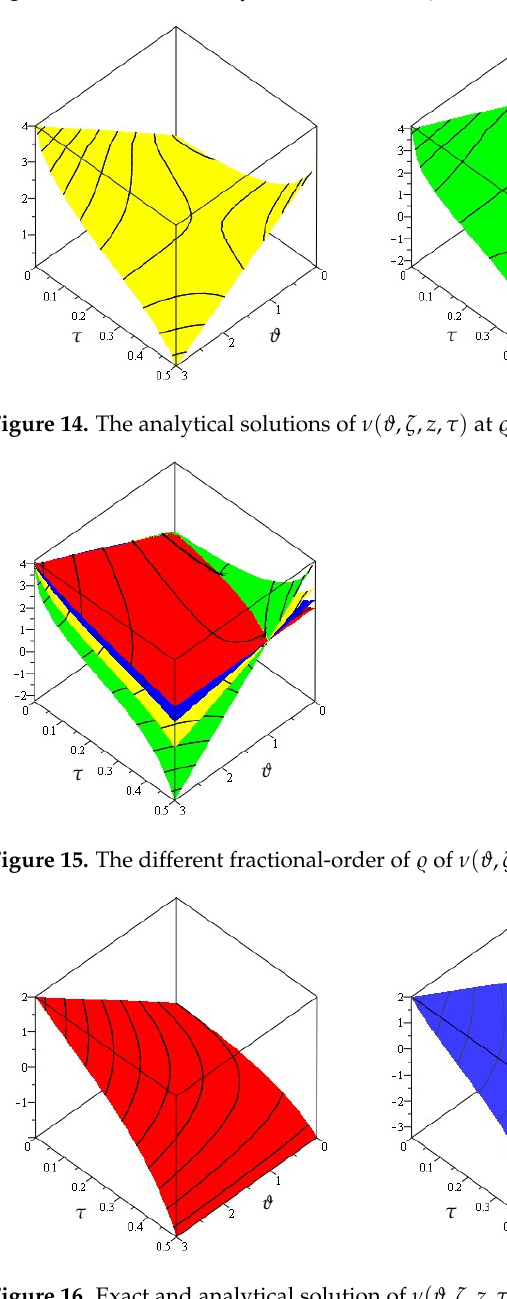
Figure 16. Exact and analytical solution of ν ( ϑ , ζ , z , τ ) at (cid:36) = 1 and 0.8 of Example